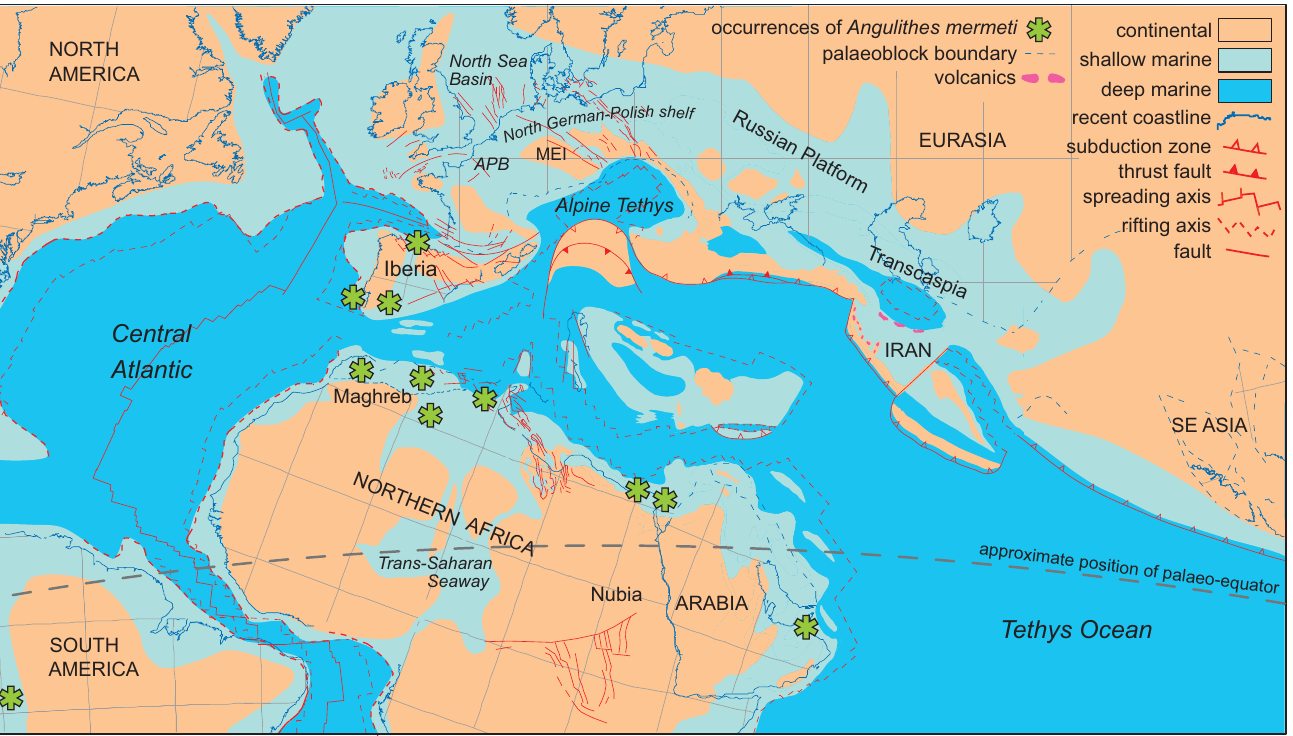
Fig. 7. Palaeobiogeographical distribution of the hercoglossid nautiloid Angulithes mermeti (Coquand, 1862). Cenomanian palaeogeographical and plate tectonic situation modified after Barrier and Vrielynck (2008); nautiloid occurrences are indicated by asterisks (see text for literature sources). Abbreviations: APB, Anglo-Paris Basin; MEI, Mid-European Island,